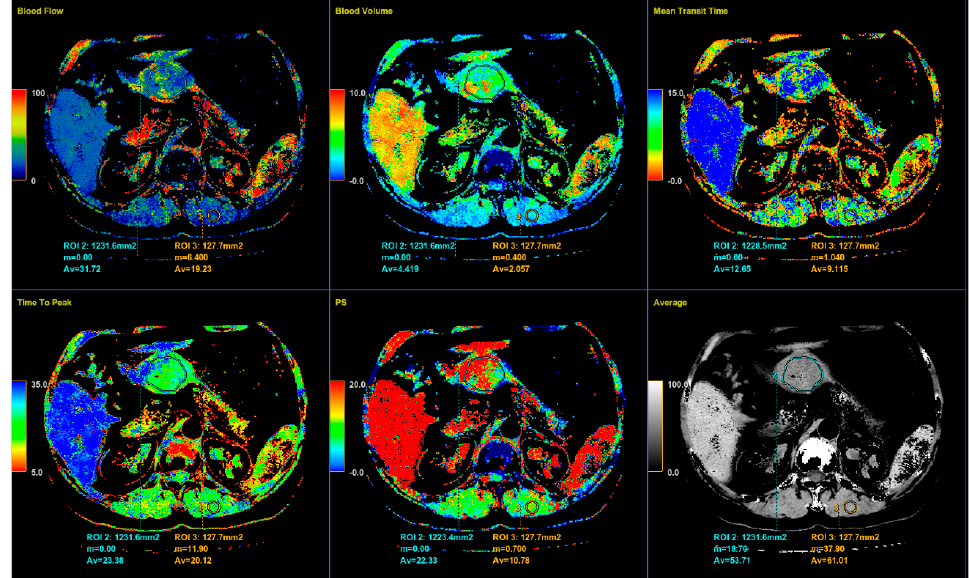
Figure 5. Color parametric maps of the same tumor and muscle ROI (area in square millimeters) automatically computed by the commercial deconvolution-based CT perfusion software. Axial CT sections show the average values of perfusion parameters BF, BV, MTT, TTP, PS, and average density measured for tumor and muscle.